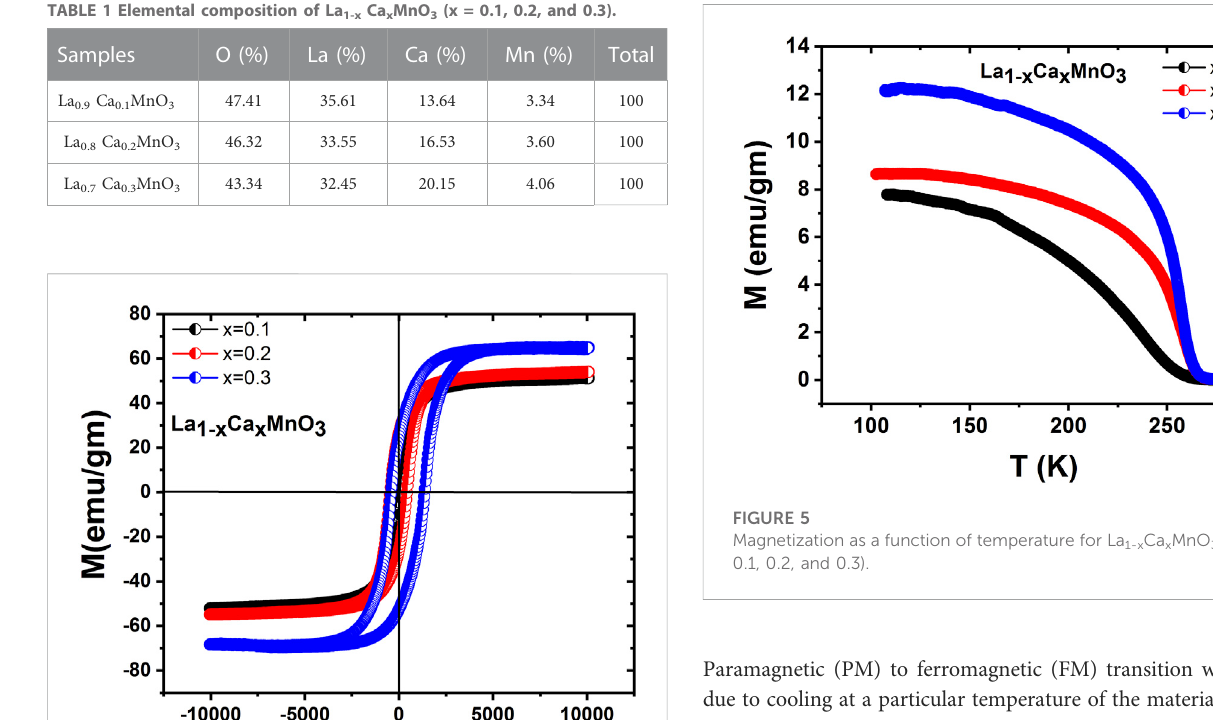
FIGURE 4 Field dependence of magnetization for La 1-x Ca x MnO 3 samples at Ca concentrations of x = 0.1, 0.2, and 0.3.